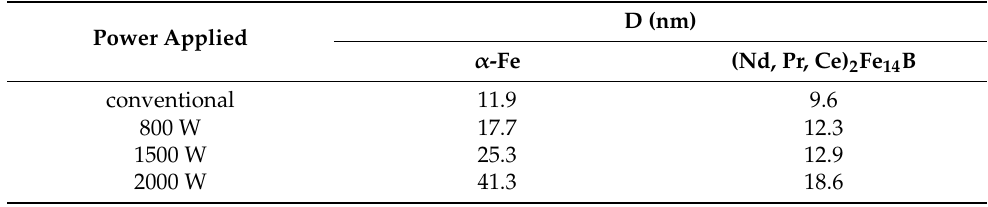
Table 1. The average crystallites size of the main phases of the microwave annealed (Nd 0.525 Pr 0.175 Ce 0.3 )